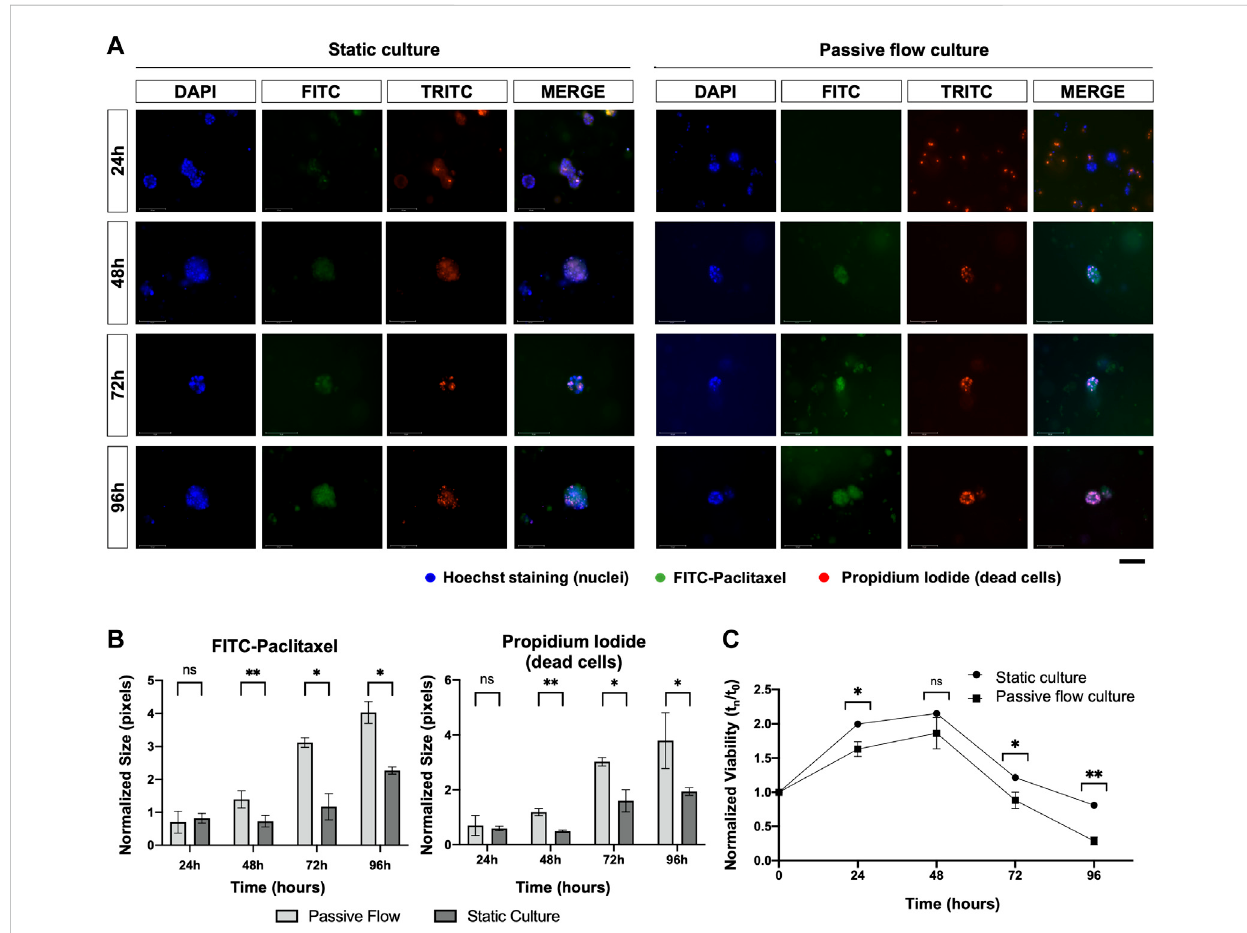
FIGURE 9 (A) Fluorescence microscopy images of organoids treated with FITC labeled with Paclitaxel (green), labeled with Hoescht 23,334 (nuclei, blue), and labeledwithEthD-1(deadcells,red).Acomparisonat24,48,72,and96 hbetweenstaticculturesandpassive fl owculturesisshown.Scalebar125 μ m; (B) Quanti fi cation of fl uorescence signal: the number of red and green pixels was normalized by the number of blue pixels and mean ± SD is reported. The p -valuewascalculatedusingatwo-tailedStudent ’ st-test.* p ≤ 0.05,** p ≤ 0.01,*** p ≤ 0.001,and**** p ≤ 0.0001; (C) Theviabilityoftheorganoids treated with the FITC labeled with Paclitaxel was measured over time using the PrestoBlue HS Assay; mean ± SD is reported, and the p -value was calculated using a two-tailed Student ’ s t -test. * p ≤ 0.05, ** p ≤ 0.01, *** p ≤ 0.001, and **** p ≤